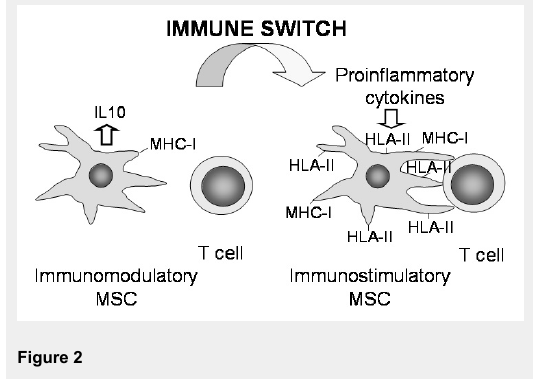
Cartoon depicting MSC immune switch. Under normal in vitro conditions (left), human MSCs express low MHC-I and no HLA class II, while secreting IL10. They mediate immunomodulatory effects on T cells. In the presence of pro-inflammatory cytokines (right), HLA class II is expressed on cell surfaces. MSCs acquire antigen presenting cell properties and stimulate T